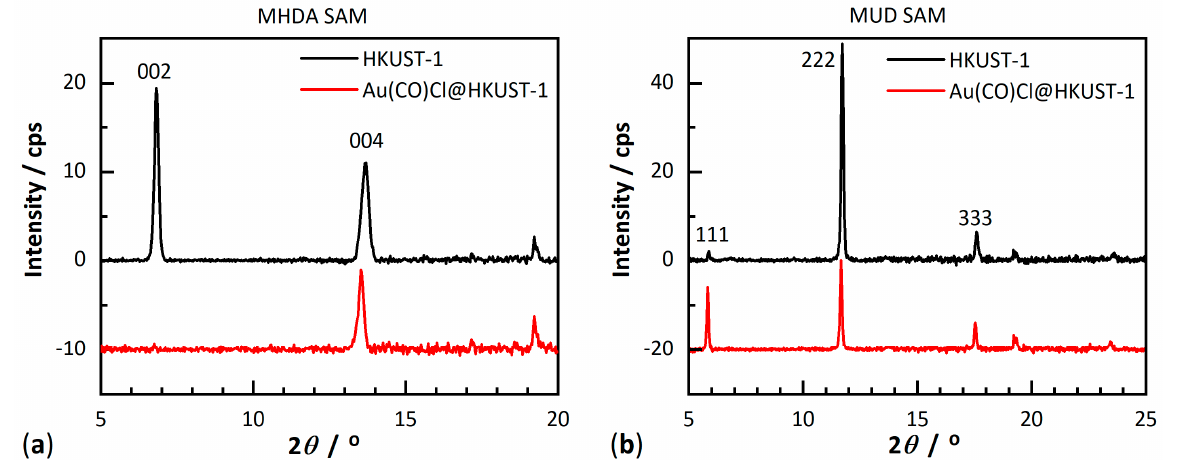
Figure 3. Powder X-ray diffraction (PXRD) patterns recorded for ( a ) empty (black) and after loading Au(CO)Cl (red) in the HKUST-1 SURMOF grown on an MHDA-SAM-modified Au substrate; ( b ) empty (black) and after loading Au(CO)Cl (red) in the HKUST-1 SURMOF grown on a MUD-SAM- modified Au substrate. The reflections are designated by the Miller indices hkl.